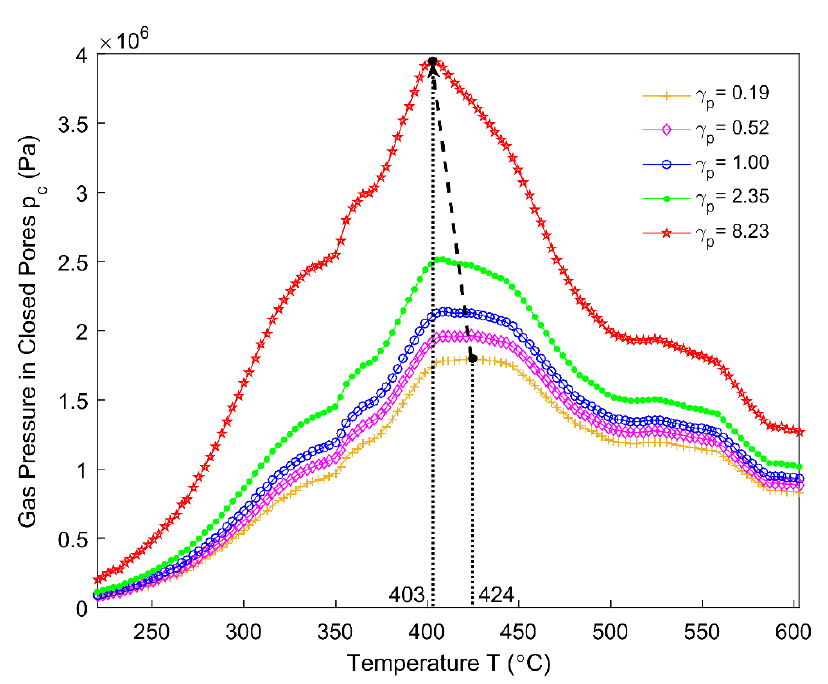
Figure 22. Gas pressure in closed pores for different permeability correlators.